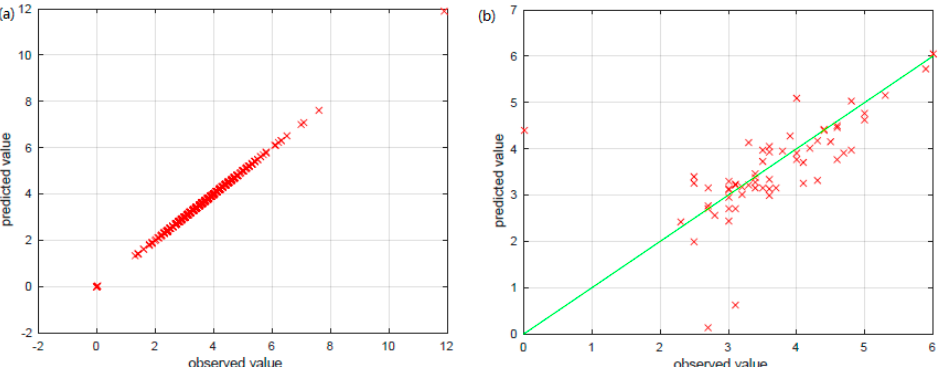
Figure 6. Prediction for ( a ) 90% of the observations which are used for training the statistical model and ( b ) for the remaining randomly chosen observations.